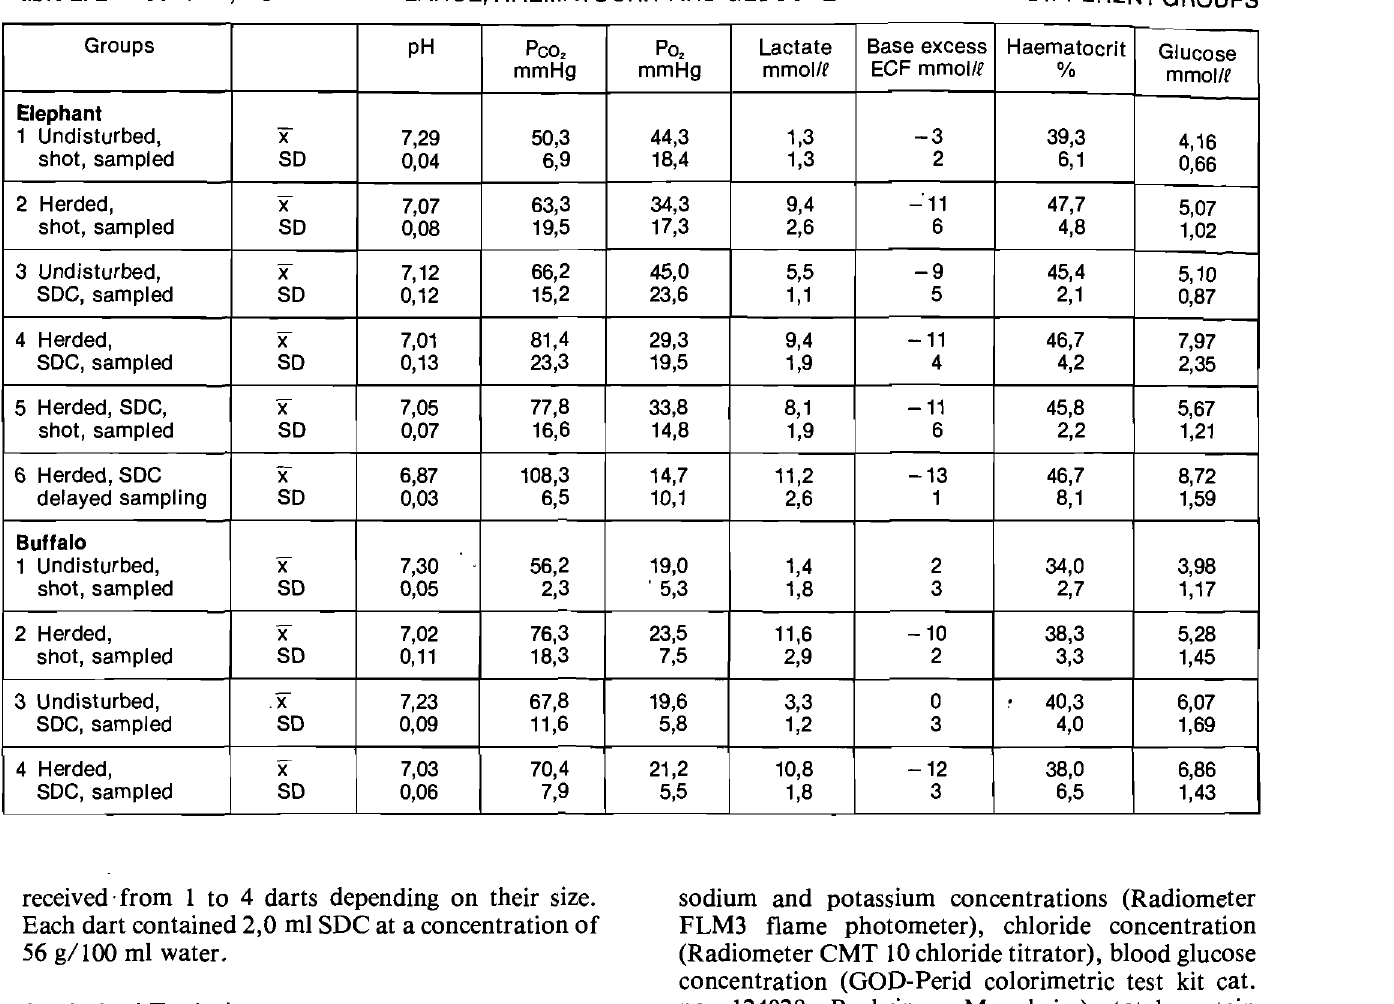
Table 2: BLOOD GAS, ACID·BASE BALANCE, HAEMATOCRIT AND GLUCOSE VALUES OF THE DIFFERENT GROUPS Groups pH Pea, Elephant 1